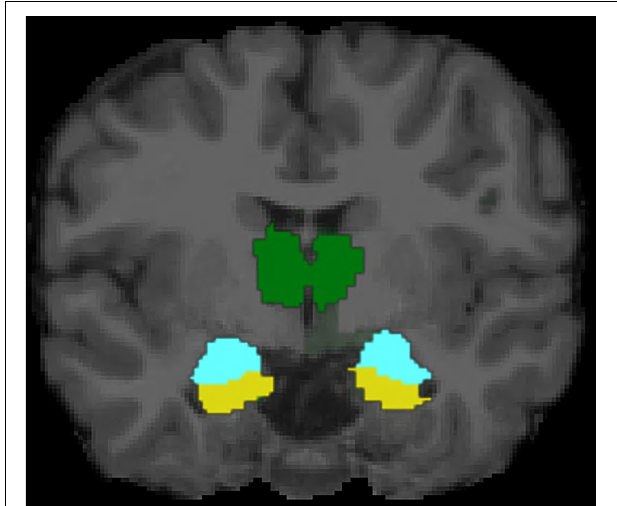
FIGURE 4 | Subcortical structures of interest in mid-coronal view. Hippocampus depicted in yellow, amygdala depicted in turquoise, and thalamus depicted in